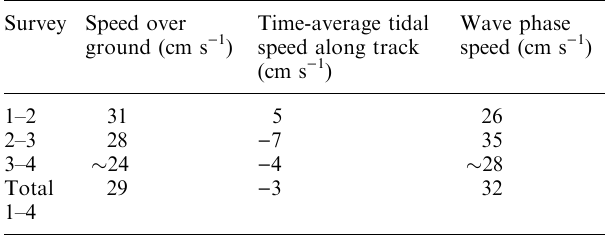
Table 1. Speed across ground and phase speeds between the surveys (west-east component) Survey Speed over Time-average tidal ground (cm s ) 1 ) speed along track